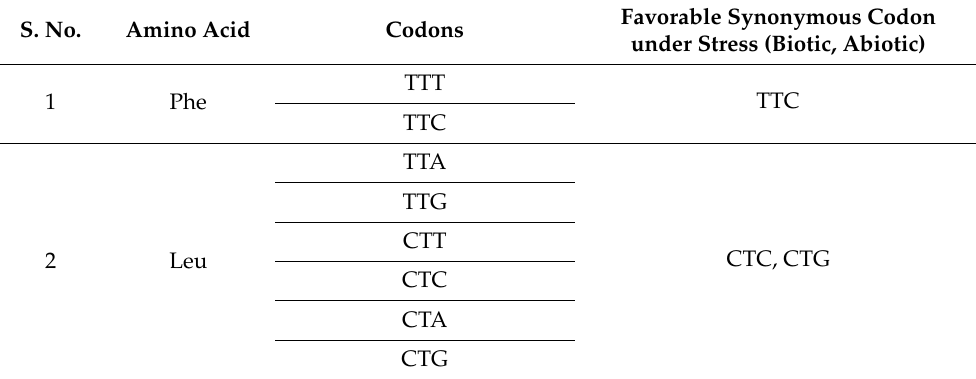
Table 2. Catalog of potentially beneficial replacement targets for synonymous change in rice